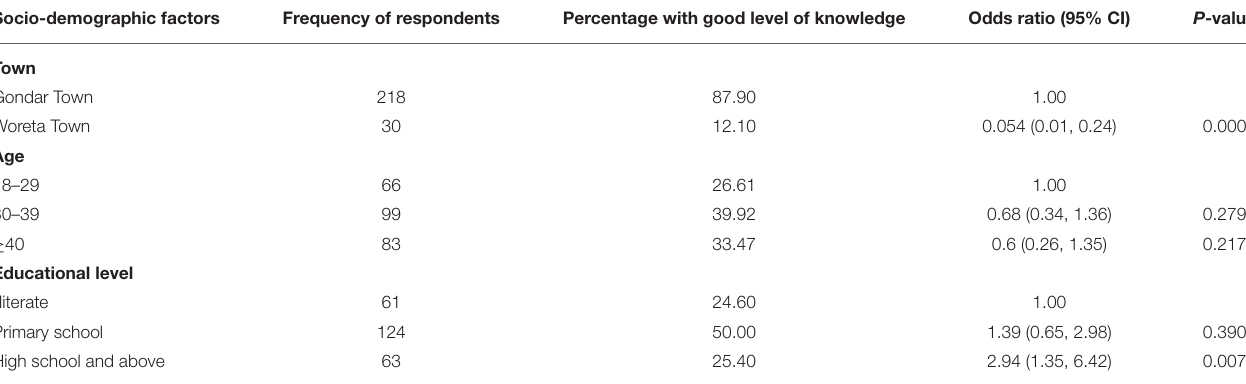
TABLE 7 | Multivariable logistic regression analysis for the association between socio- demographic factors and knowledge level of epizootic lymphangitis. Socio-demographic factors Frequency of